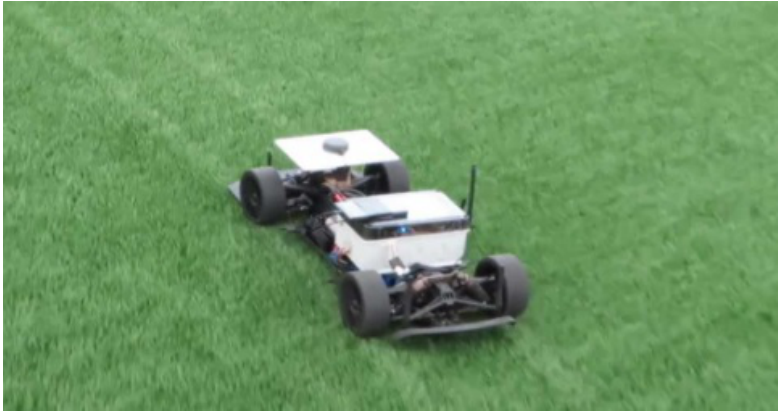
Figure 1. RC car as